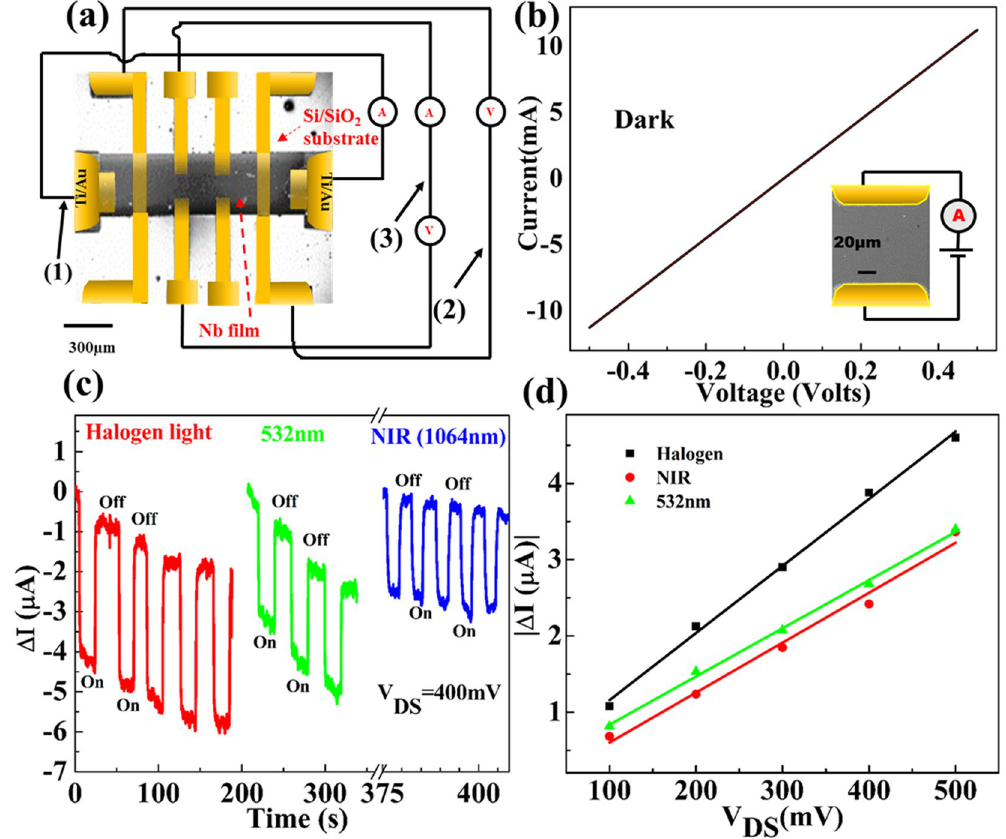
Figure 1. Room temperature photo-response of a NNF device. ( a ) The device geometry and the measurement connections. Room temperature two-probe measurements are done through the terminals marked as (3) and low temperature 4-probe measurements are with (1) & (2) connections. ( b ) Current-voltage characteristic of NNF at room temperature in dark condition. Inset: A magnified SEM image of the NNF device measured in two probe geometry. ( c ) Time dependent measurement of Δ I for repetitive cycles of light ‘On’ and ‘Off’ states under